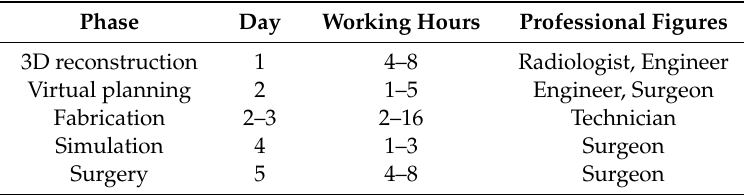
Table 1. Timing data of the simulation process.